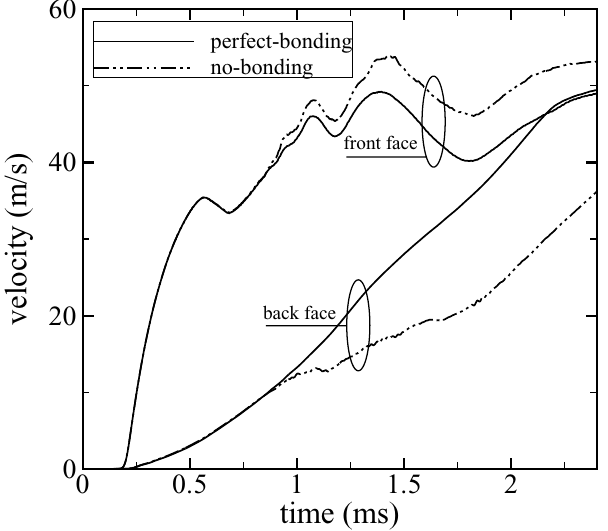
Fig. 7. Comparison of the mid-span velocity history between the perfect- and no-bonding sandwich plates with clamped ends. behaviors due to the above mentioned